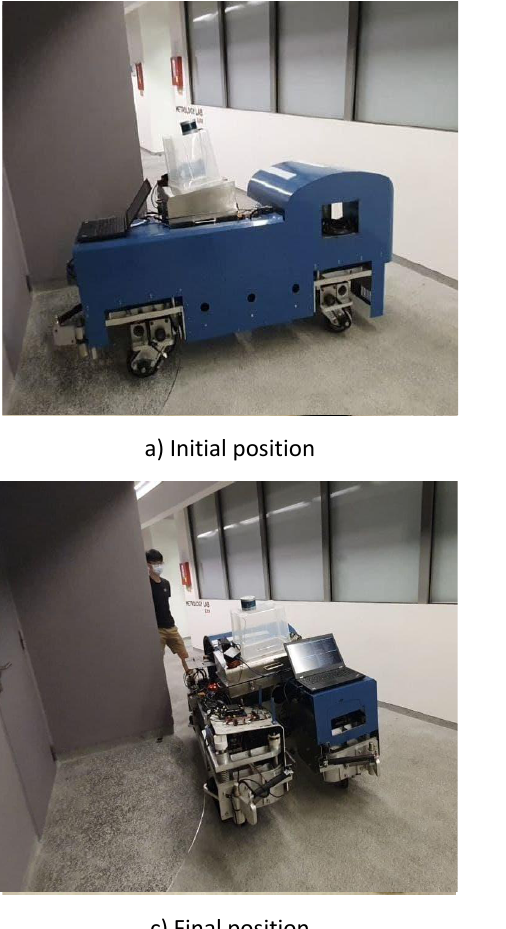
Figure 9. Rotation near a wall depicting Scenario S2 (Figure